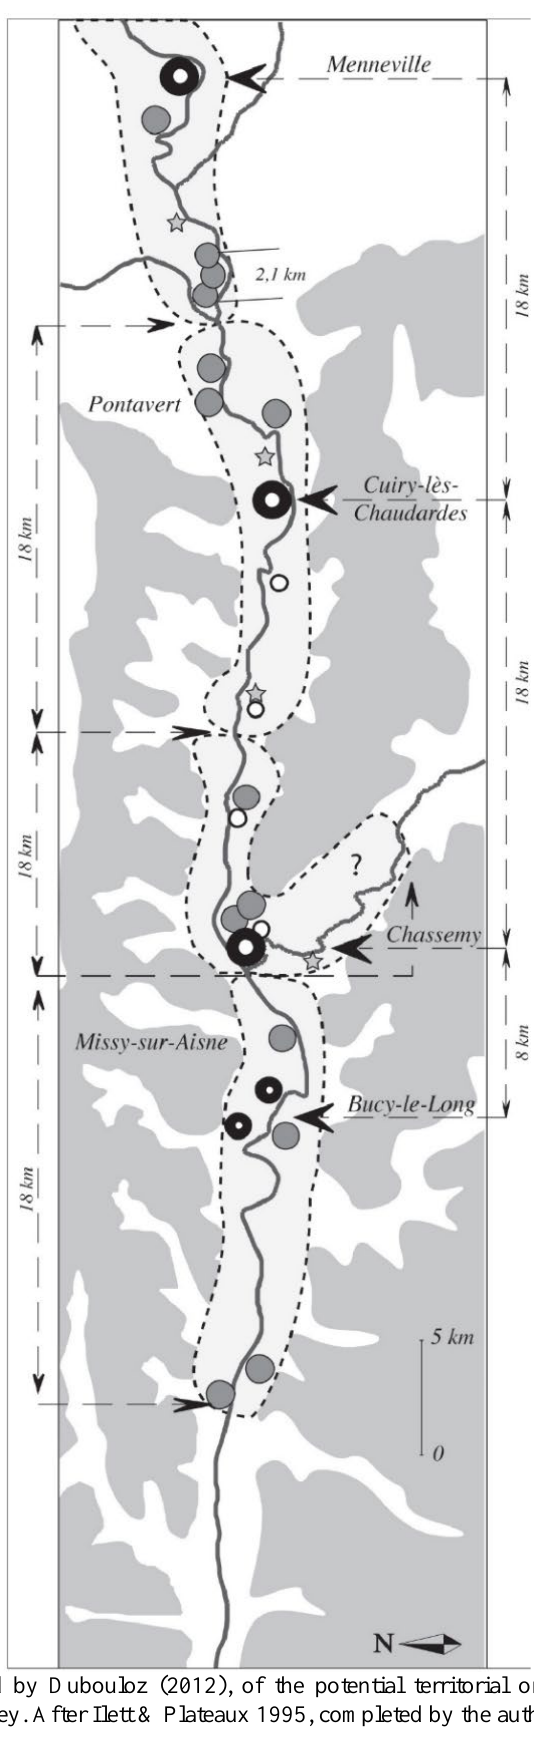
Figure 3. Diagram, proposed by Dubouloz (2012), of the potential territorial organization of Linear Pottery Culture sites in the Aisne valley. After Ilett & Plateaux 1995, completed by the